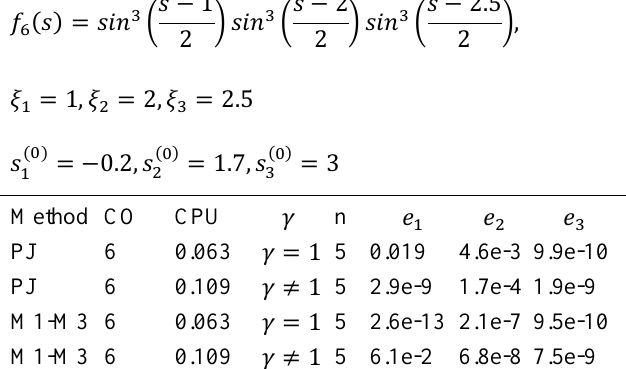
Simultaneous determination of all roots